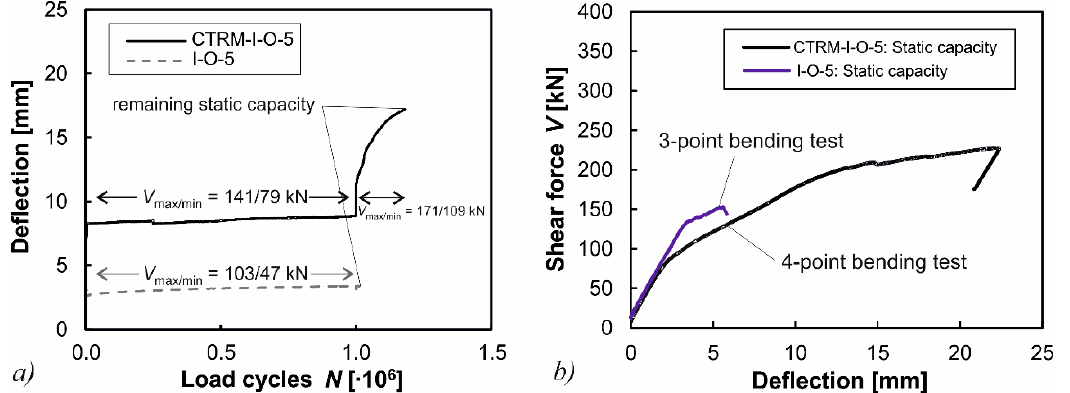
Figure 11. ( a ) Comparison of vertical deflections under cyclic loading for tests without shear reinforcement; and ( b ) the comparison of the remaining shear capacities of non-strengthened and strengthened specimens.